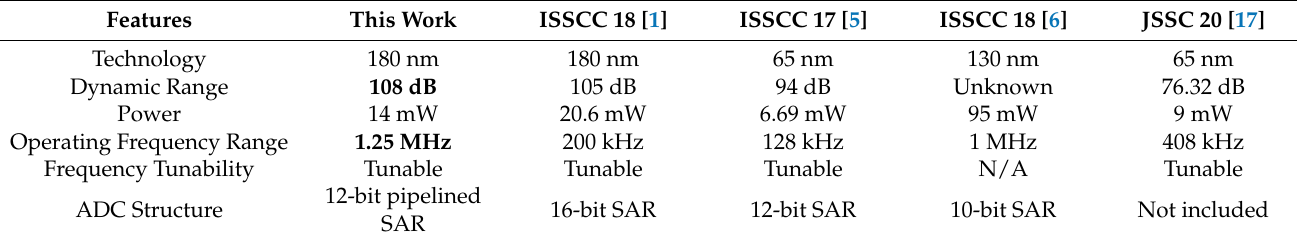
Figure 11. ADC output spectrum with 473 kHz input in stand-alone mode.